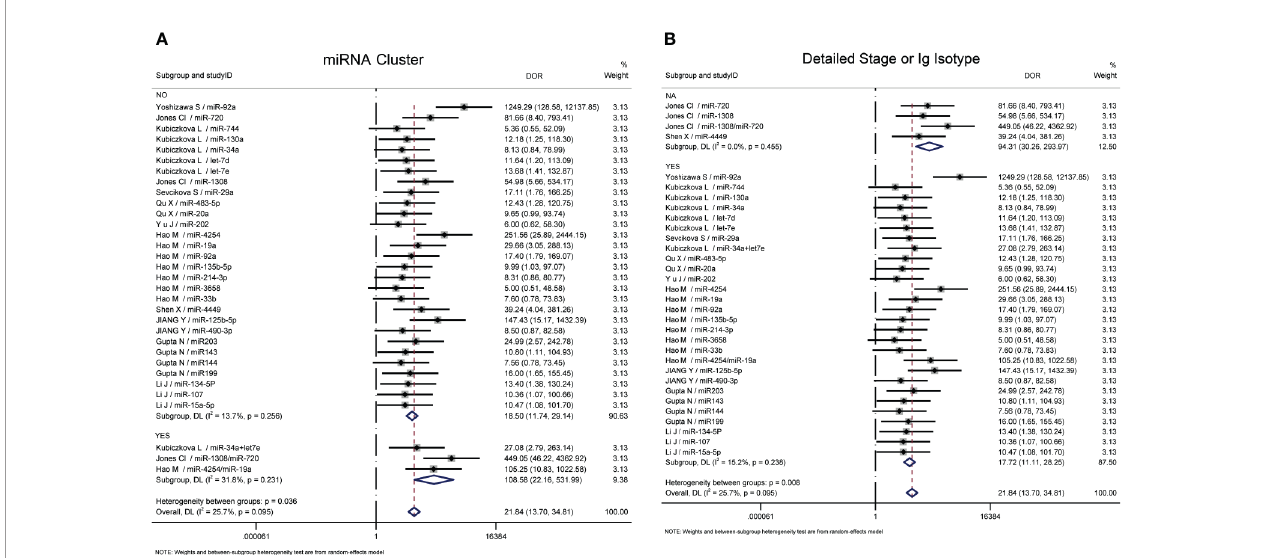
FIGURE 6 | Subgroup analysis. (A) Subgroup analysis based on DOR sorted by “ miRNA cluster ” ; (B) Subgroup analysis based on DOR sorted by “ detailed stage or Ig isotype ” . NA, not available.